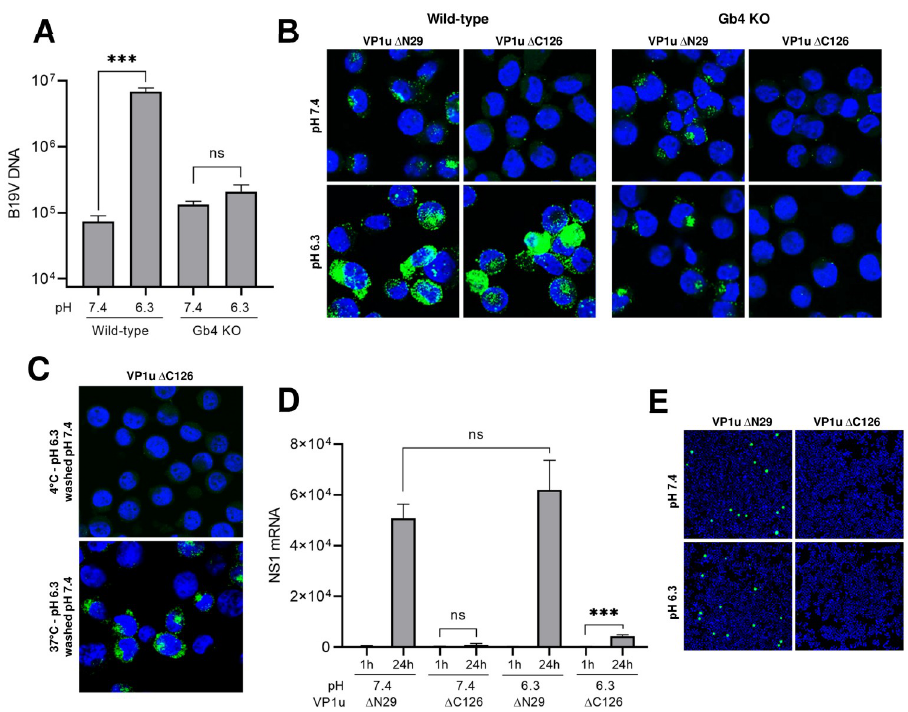
Fig 6. Low pH-mediated interaction of B19V with Gb4 initiates active membrane processes. (A) Quantification of B19V attachment to UT7/Epo WT and Gb4 KO cells at neutral and acidic pH. Cells were infected with B19V (10 4 geq/ cell) at 37˚C for 1h followed by four washes. DNA was extracted and quantified by qPCR. The results are presented as the mean ± SD of three independent experiments. ��� p < 0.001; ns, not significant. (B) Detection of B19V capsids (860- 55D) in UT7/Epo WT and Gb4 KO cells under neutral or acidic pH by IF. Cells were incubated for 30 min with functional ( Δ C126)to block the VP1uR or non-functional ( Δ N29)recombinant VP1u, as a control (S1 Fig) at